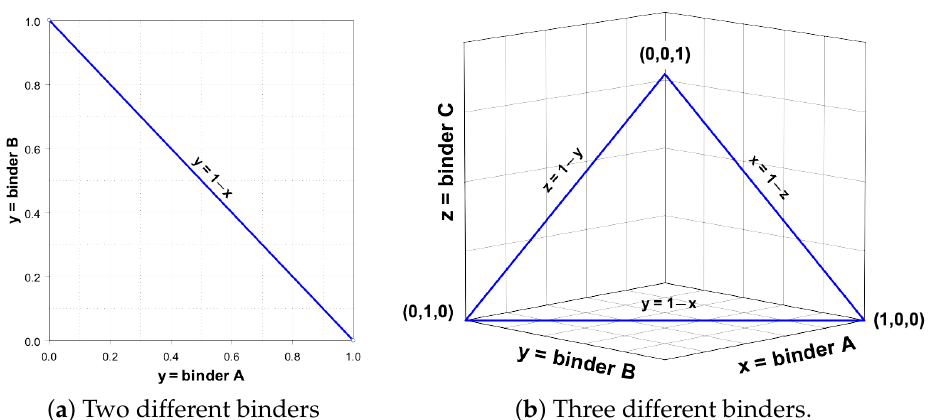
Figure 4. Application of simplex lattice design showing possible binder